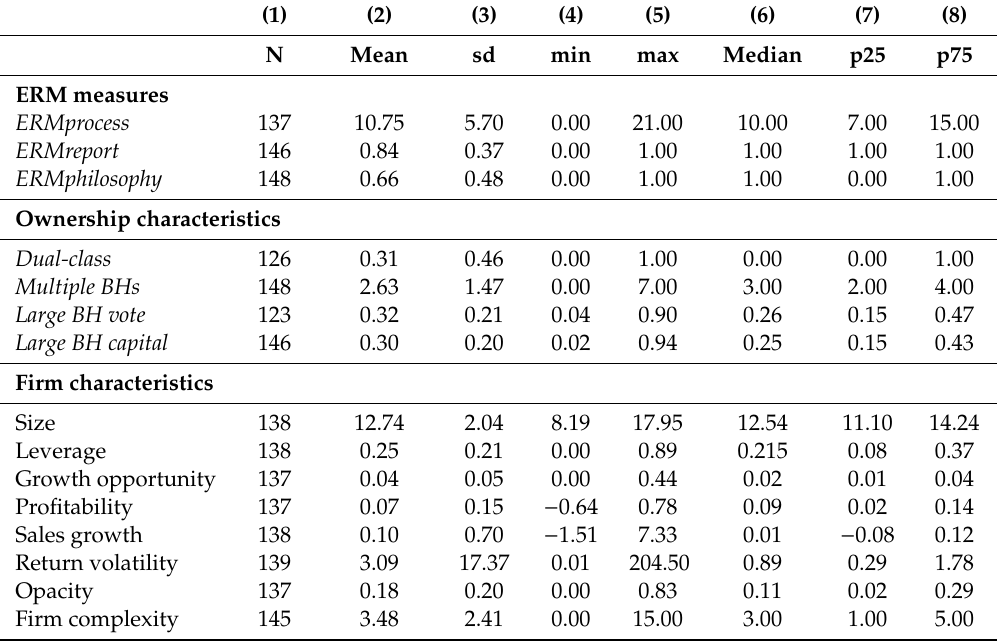
Table 2. Summary